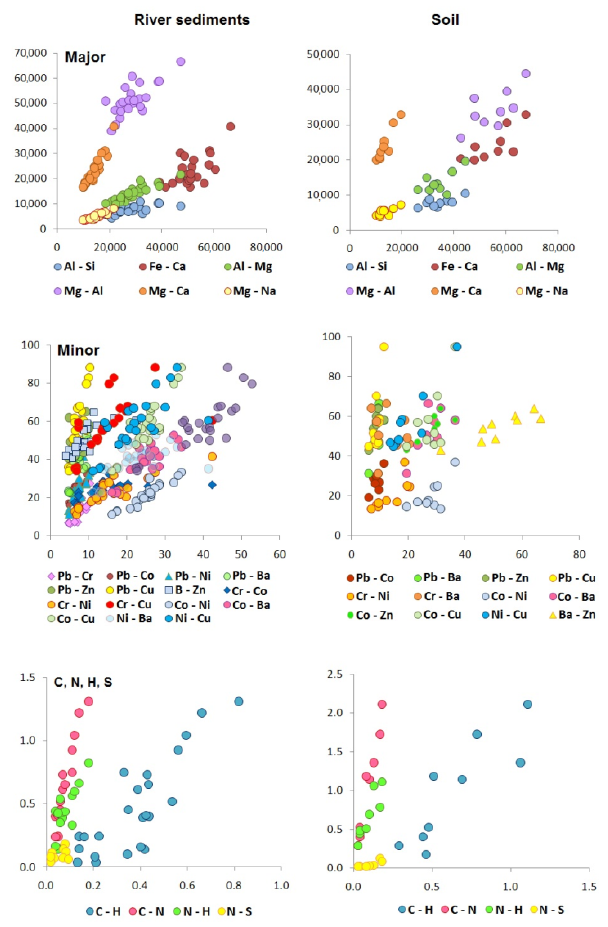
Figure 4. The most significant bi-variant correlations among elements in river sediments and soil. On the other hand, C—N correlation in soil ( r = 0.981 and p = 0.01) is the